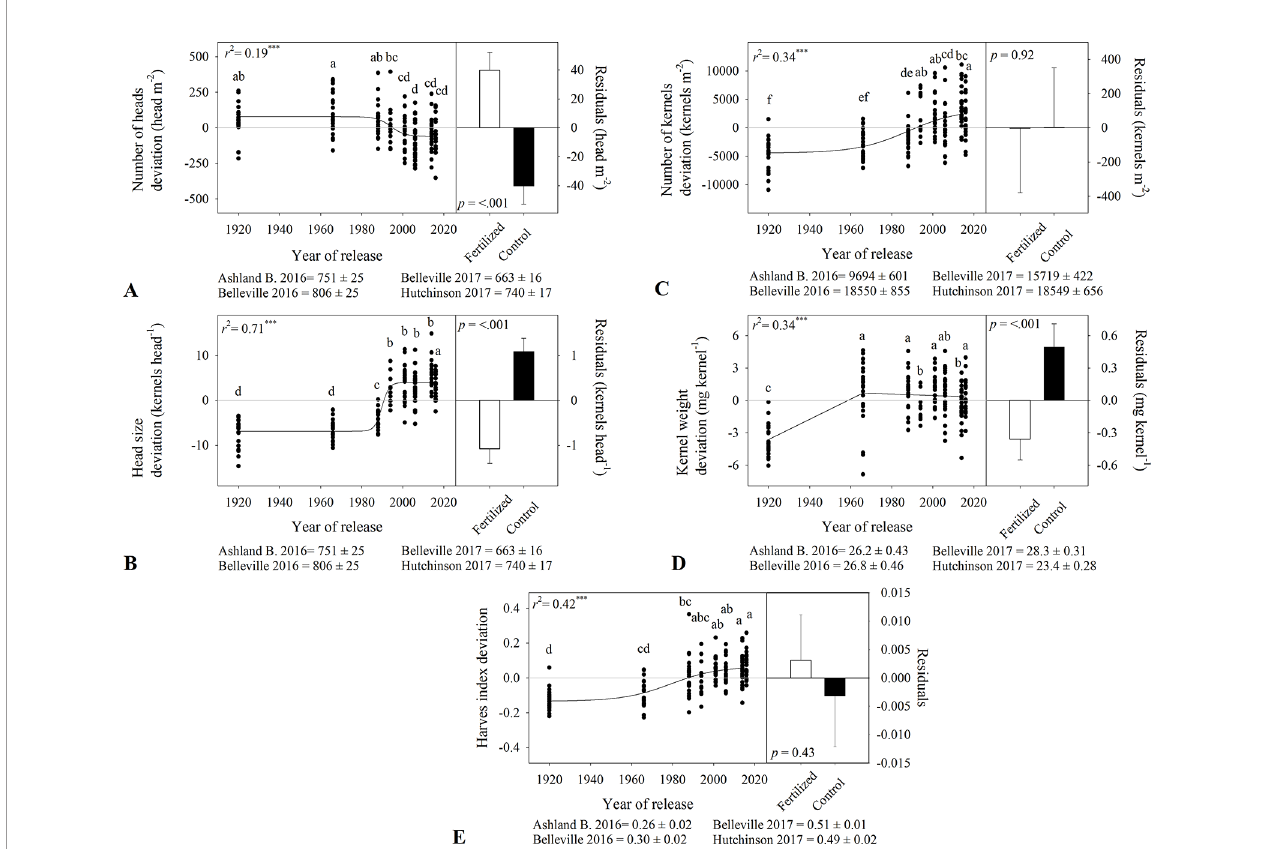
FIGURE 4 | Relationship between the year of release and yield components deviation including (A) heads number, (B) head size, (C) kernel number, (D) kernel weight, and (E) harvest index. Comparison of the regression residuals for in-furrow fertilizer treatment and no control (mean and one standard error). Values correspond to the data of four site years during two growing seasons (2016-2017 and 2017-2018). Mean for all varieties in each site and year. All models are signi fi cant at P < 0.0001. Varieties followed by the same letter are not statistically different at a =